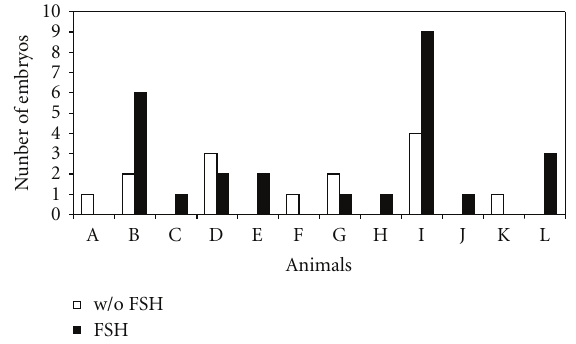
Figure 2: Blastocyst yields from the animals subjected to OPU without FSH (open bars) and OPU with FSH treatment (solid